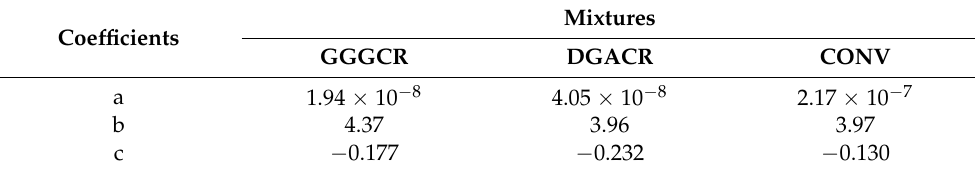
Table 9. Parameters for the monthly damage (Equation